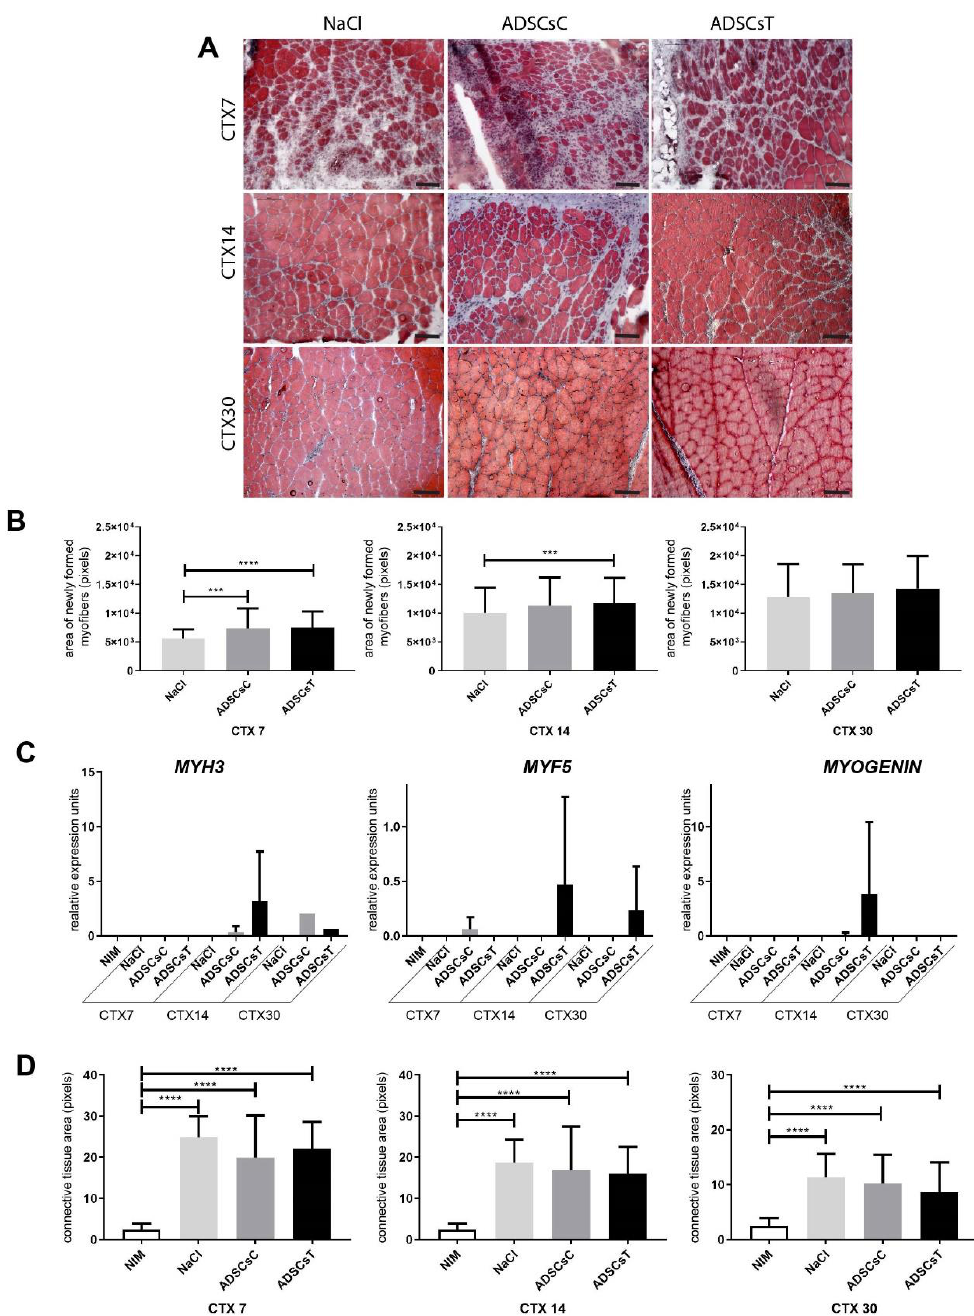
Figure 10. Regeneration of mouse skeletal muscles which received control hADSCs or hADSCs pretreated with IL-4 and SDF-1. ( A ) Morphology of regenerating mouse muscles at day 7, 14, and 30 of regeneration, Masson’s Trichrome staining, bar = 100 µm. ( B ) Area of newly formed myofibers within the regenerating muscle analyzed at day 7, 14, and 30 of regeneration. (C) Expression of human mRNAs encoding MYH3, MYF5, and MYOGENIN in control and regenerating muscles. Expression was normalized to mRNA encoding HPRT. ( D ) Connective tissue area calculated from the histological sections analyzed at day 7, 14, and 30 of regeneration. NIM—non-injured muscle, ADSCsC—muscle transplanted with control ADSCs, ADSCsT—muscle transplanted with treated ADSCs. CTX7 - day 7; CTX14 - day 14; CTX30 - day 30 of regeneration, For each experimental group n ≥ 3. Data are presented as mean ± SD. Data have been analyzed using Kruskal-Wallis test. * p < 0.05; ** p < 0.01, *** p < 0.001, **** p <